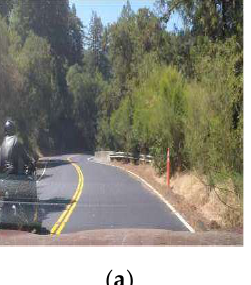
Figure 2. Image comparison of the raw and local OSTU segmentation: ( a ) Raw image; ( b ) Image of local OTSU segmentation.